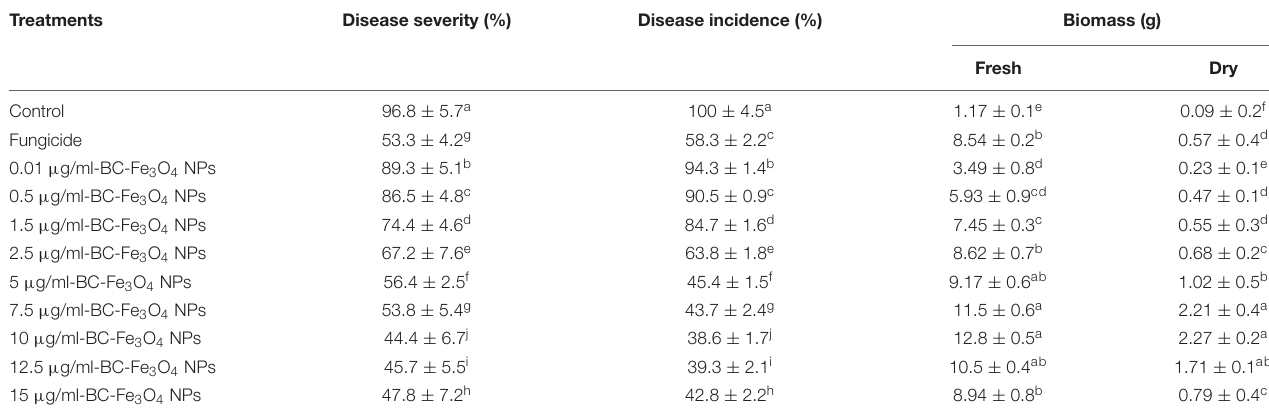
TABLE 3 | Evaluation of BC-Fe 3 O 4 NPs against Fusarium wilt of tomato under greenhouse conditions. Treatments Disease severity